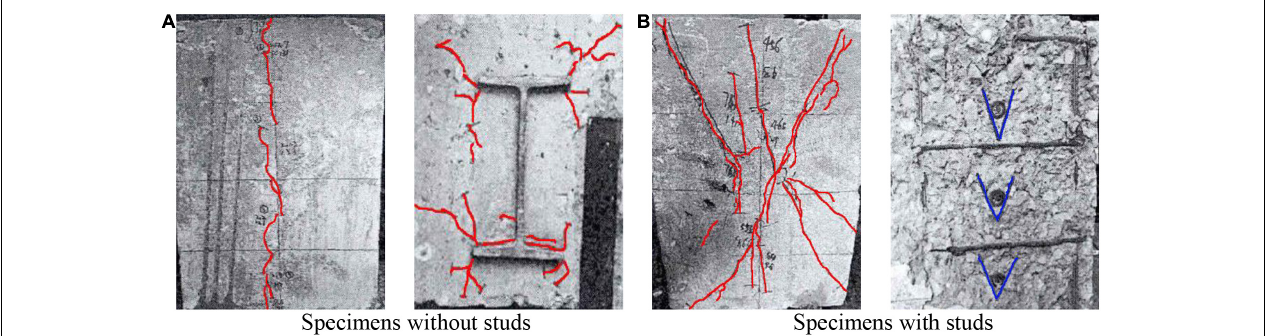
FIGURE 4 | Failure modes of specimens. (A) Specimens without studs. (B) Specimens with studs.